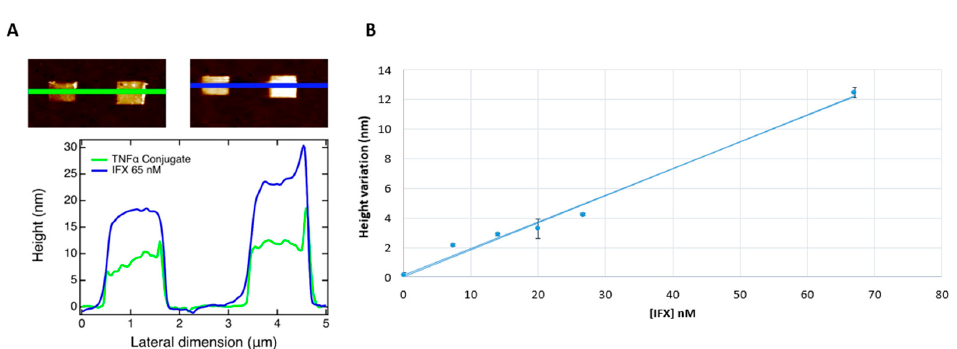
Abbreviations: IBD, inflammatory bowel disease.